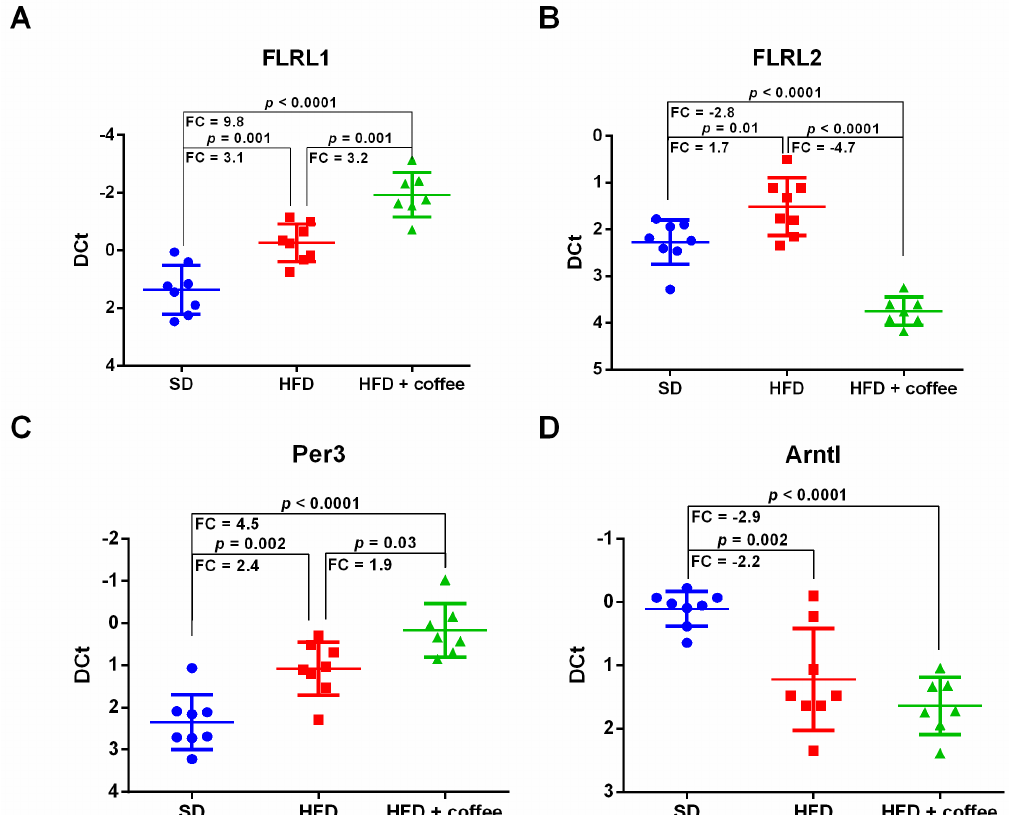
Figure 4. Hepatic expression of fatty liver-related lncRNA 1 (FLRL1) (Panel A ), Fatty liver-related lncRNA 2 (FLRL2) (Panel B ), period circadian protein homolog 3 (Per3) mRNA (Panel C ) and Aryl hydrocarbon receptor nuclear translocator- like protein 1 (Arntl) mRNA (Panel D ), analyzed through qPCR, in mice fed standard diet (SD), high fat diet (HFD) and HFD plus decaffeinated coffee; n = 23: 8 SD, 8 HFD, 7 HFD+ coffee. Transcript statistical significance was evaluated with one-way ANOVA with Tukey post-hoc test for multiple comparisons (two-tailed p -value < 0.05); FC = fold